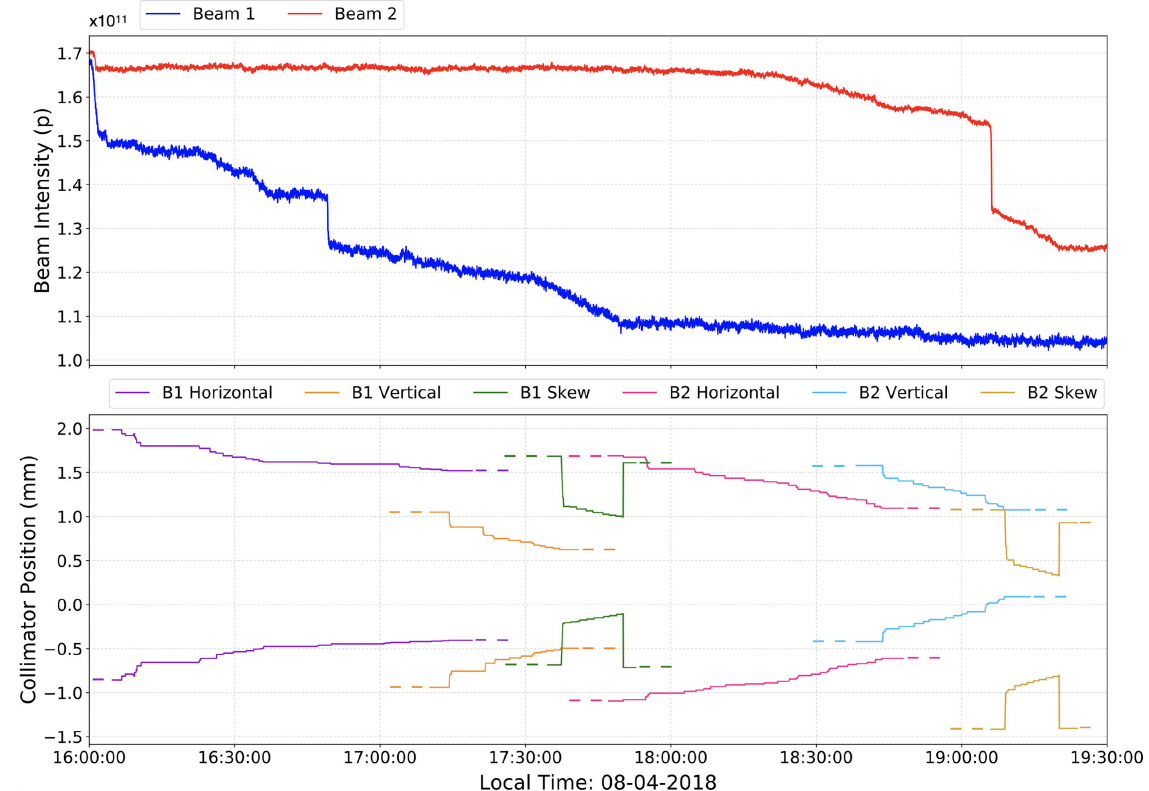
FIG. 9. Sequential alignment of the collimators in the two beams at flattop, showing the beam intensities and only the jaw positions of the primary (TCP) collimators for